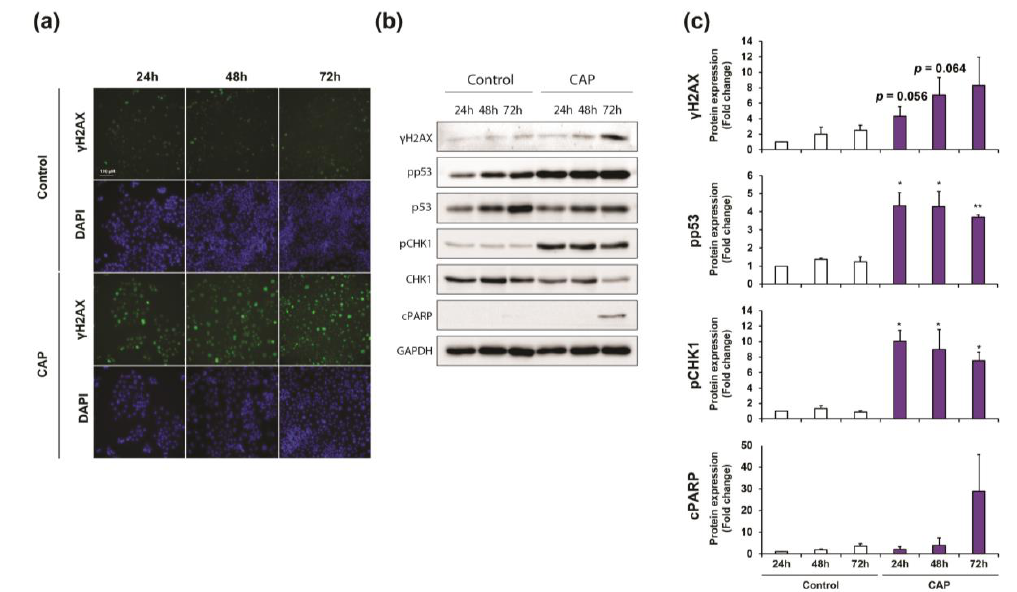
Figure 6. cont. Figure 6. Cont